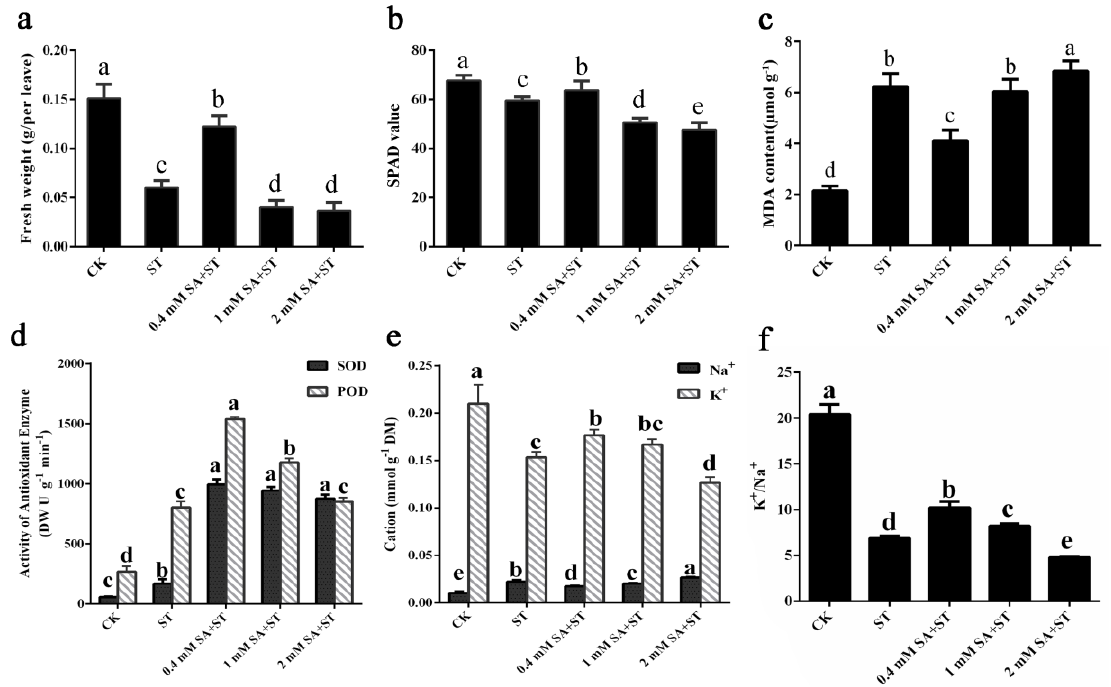
Figure 3. E ff ects of SA on the chlorophyll, fresh weight, MDA, SOD, and POD in P. euphratica grown under salt stress. ( a ) Chlorophyll content indicated by chlorophyll meter SPAD-502. ( b ) Fresh weight. ( c ) E ff ects of application di ff erent concentrations of SA on the malondialdehyde (MDA) content of P. euphratica grown under salt stress. ( d ) SOD (black) and POD (oblique line): activities of P. euphratica grown under salt stress with or without di ff erent concentrations of SA pretreatment. ( e ) Na + (black) and K + (oblique line): contents of leaves with di ff erent treatment. ( f ) K + / Na + ratio with di ff erent treatment. ST means salt treated, 0.4 mM SA + ST, 1.0 mM SA + ST and 2.0 mM SA + ST indicate di ff erent concentrations of SA solution plus with subsequent 300 mM salt treatment, respectively. CK refers to P. euphratica grown under natural conditions without any treatments. ST means P. euphratica treated only with 300 mM NaCl. n mM SA + ST stands for P. euphratica which was pretreated with n mM SA and then treated with 300 mM NaCl ( n = 0.4, 1, 2). To determine significant di ff erences between treatments, Duncan’s Test was applied. Data indicate mean ± SE ( n = 3). The di ff erent letters present on the column indicate significant di ff erences at p < 0.05.